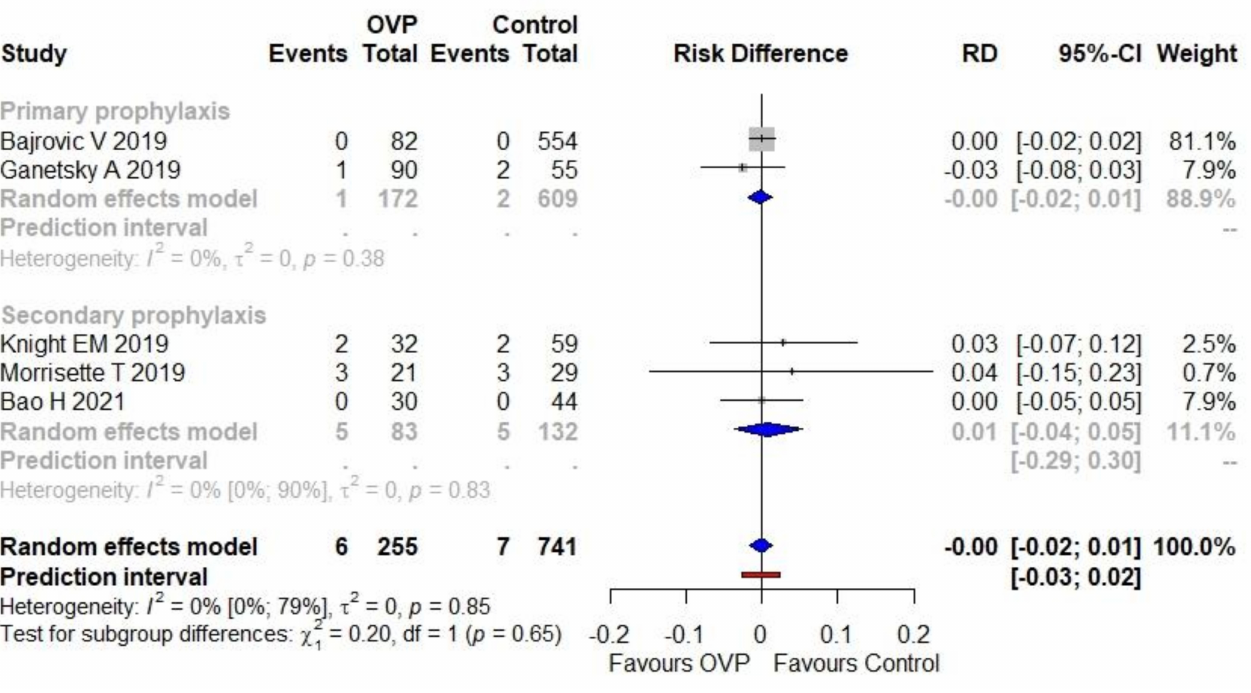
Figure 5. Meta-analysis regarding the risk difference between OVP group and comparators as the secondary outcome (VRE infections). Abbreviations: CDI, Clostridioides difficile infection; OVP, oral vancomycin prophylaxis; RD, risk difference; VRE, vancomycin-resistant Enterococci ; 95%-CI, confidence intervals at 95%. Vertical line indicates the ‘no difference’ point between the two options. Squares represent adjusted odds ratios. Diamonds represent pooled risk difference for all studies. Horizontal lines represent 95%